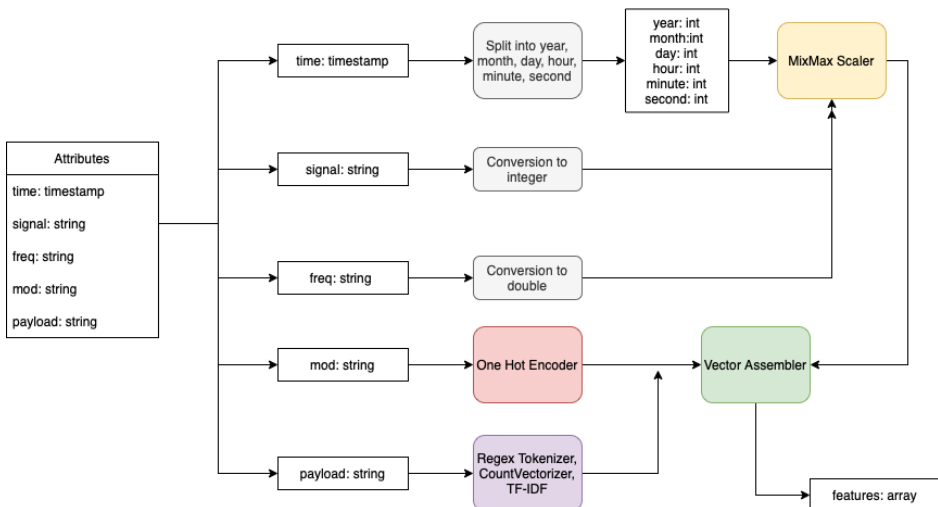
Figure 6. Preprocessing flow of Radio Frequency device